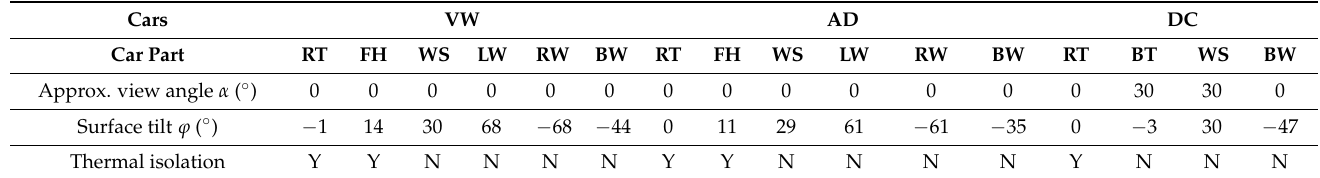
Table 4. Summary of studied car surfaces properties: Tilt angle, presence of thermal isolation, approximations used for the view angles of obstacles seen from the different car surfaces (from Table 2). Angles are counted in the trigonometric order. RT: rooftop; FH: front hood; BT: back trunk; WS: windshield; LW: left window; RW: right window; BW: back